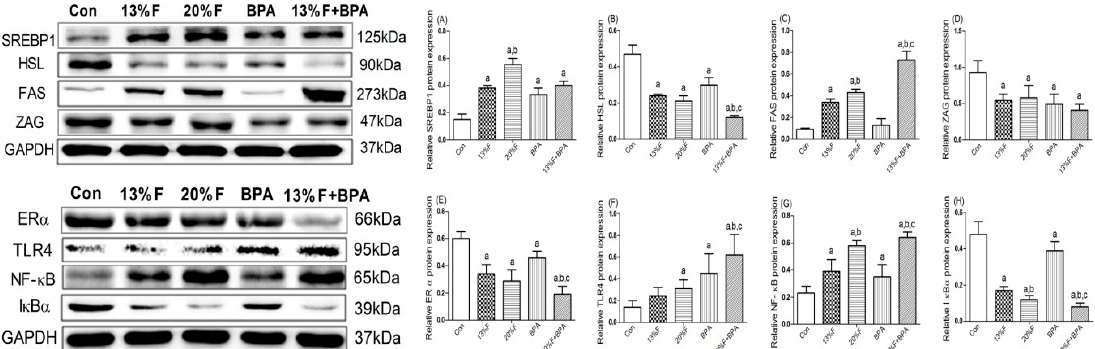
Figure 5. Hepatic protein levels in rats were analyzed by western blot, respectively. GAPDH protein was used as a control. ( A ) SREBP1 protein level. ( B ) HSL protein level. ( C ) FAS protein level. ( D ) ZAG protein level. ( E ) ER α protein level. ( F ) TLR4 protein level. ( G ) NF- κ B protein level. ( H ) I κ B α protein level. Values are expressed as means ± SD, n = 4. Differences between groups were considered as significant at p < 0.05 and were analyzed with one-way ANOVA. a different compared to Con; b different compared to 13% F; c different compared to BPA ( p < 0.05). Con, control group; F, fructose group; BPA, 1 µg/mL BPA group.